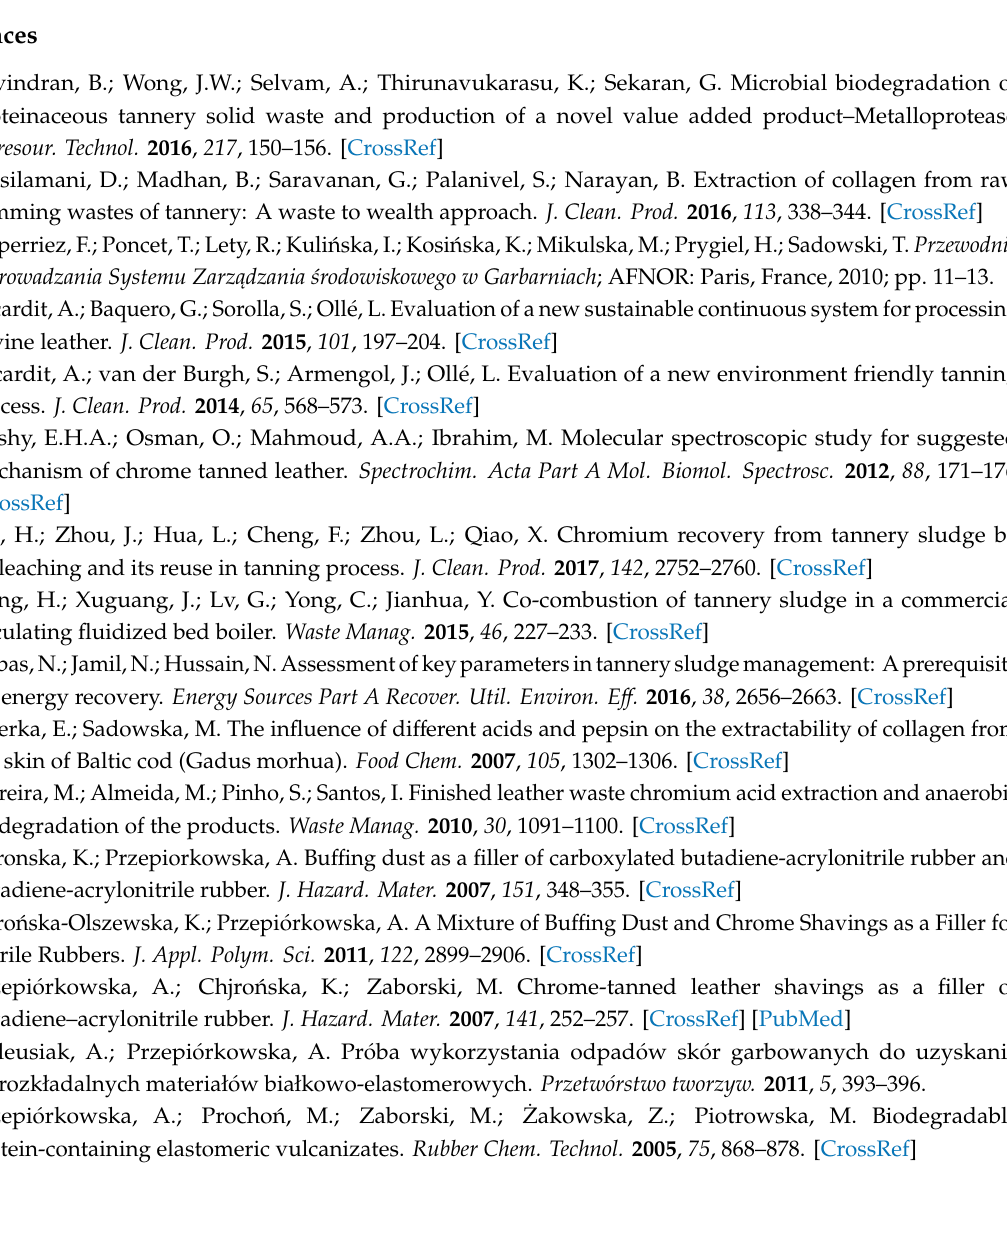
Table S1: BDC Dust characteristic characteristics; Figure S1: BDC Oil number (the sample weight was 4.3 g at 125 rpm and the dosing frequency was 4.0 mL /